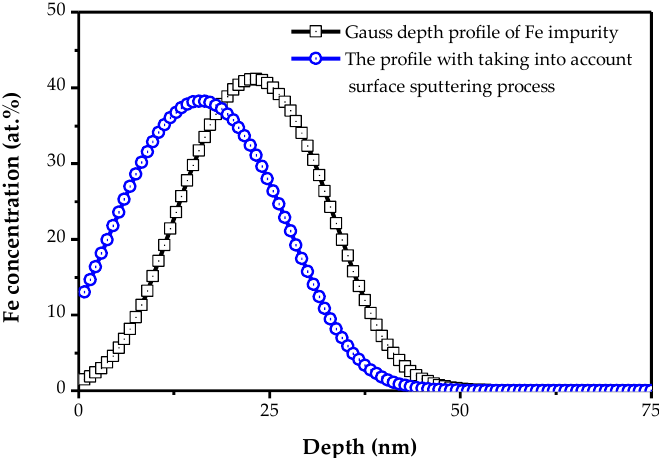
Figure 1. SRIM calculation of depth profile of iron ions implanted to MgO.